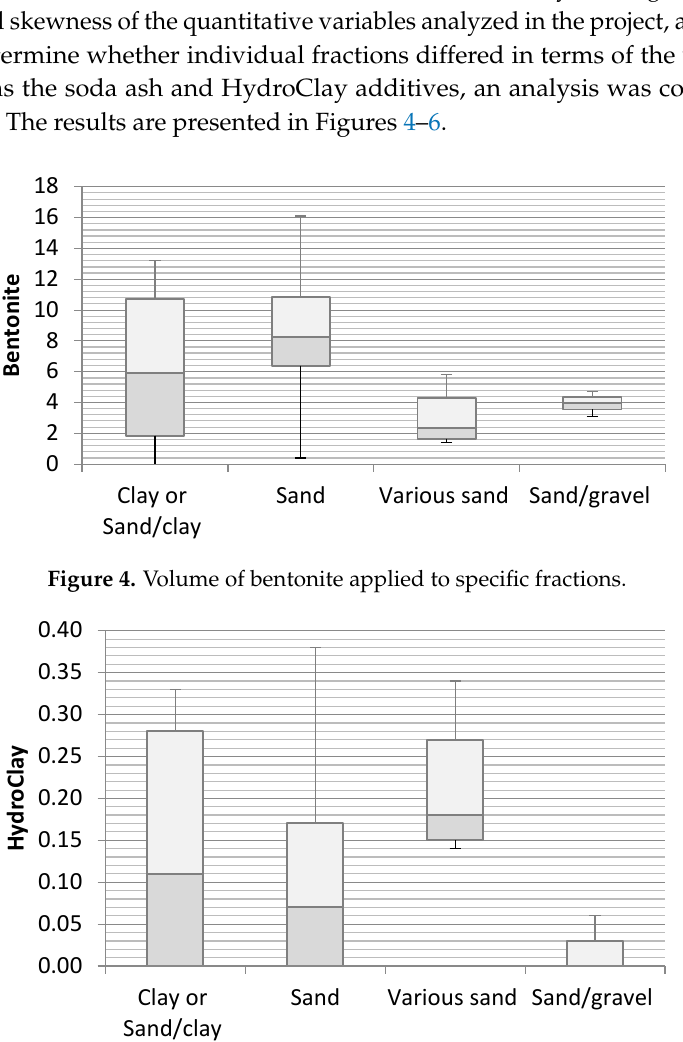
Figure 5. Volume of soda ash additive applied to specific fractions.